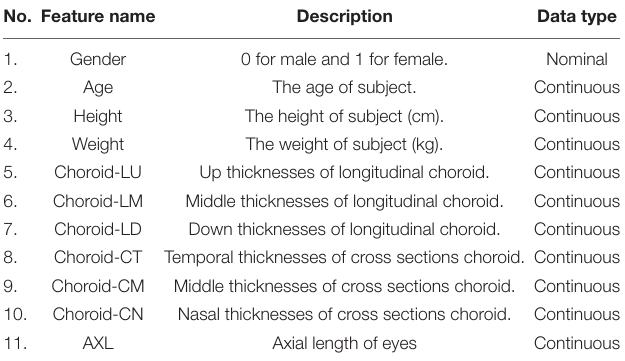
TABLE 1 | Features in this